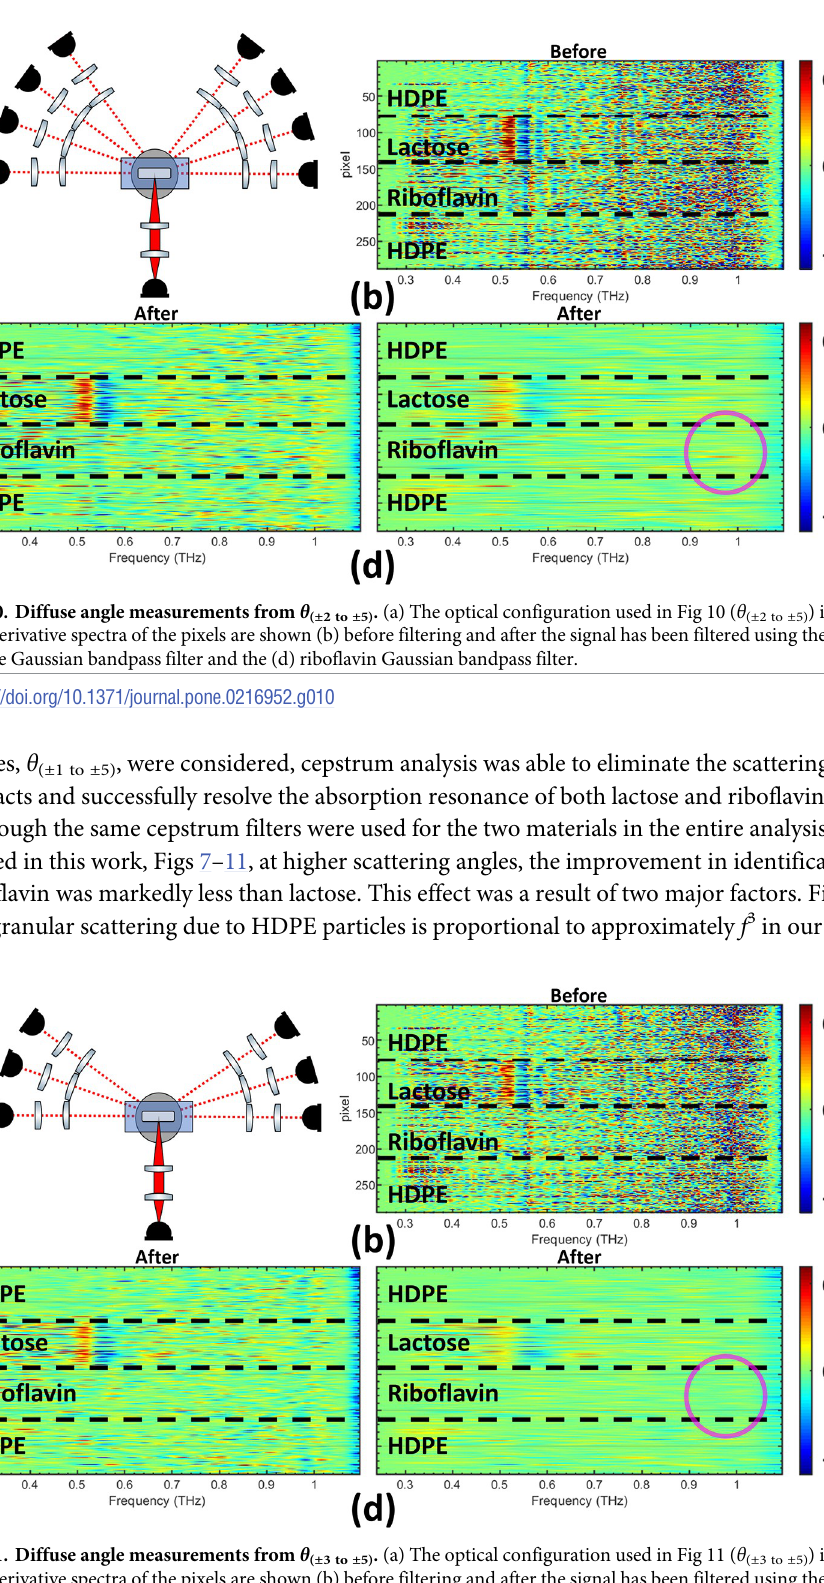
) is shown. ± 3 to ± 5)